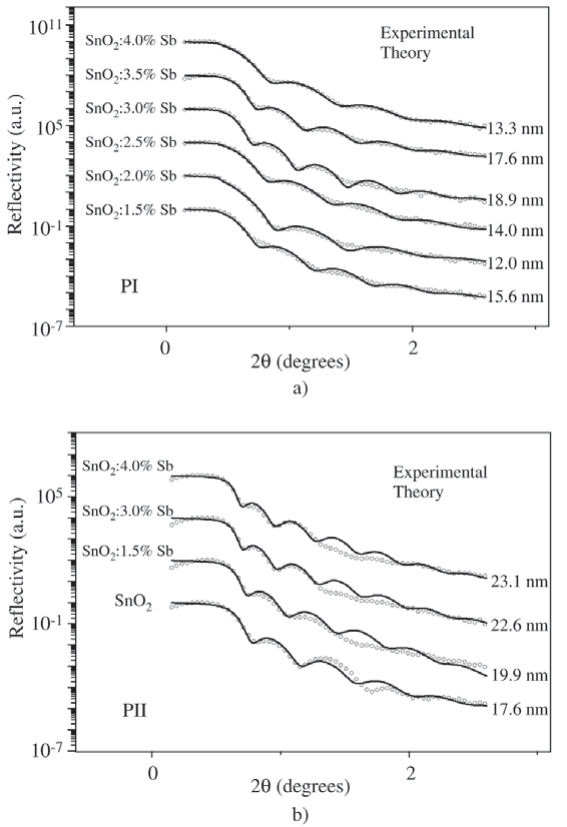
Figure 3. Experimental X-ray reflectivity curves (points) and fit- ted curves (lines) for Sb - doped SnO :Sb thin films 2 PI, single dip; b) films deposited by PII with 3